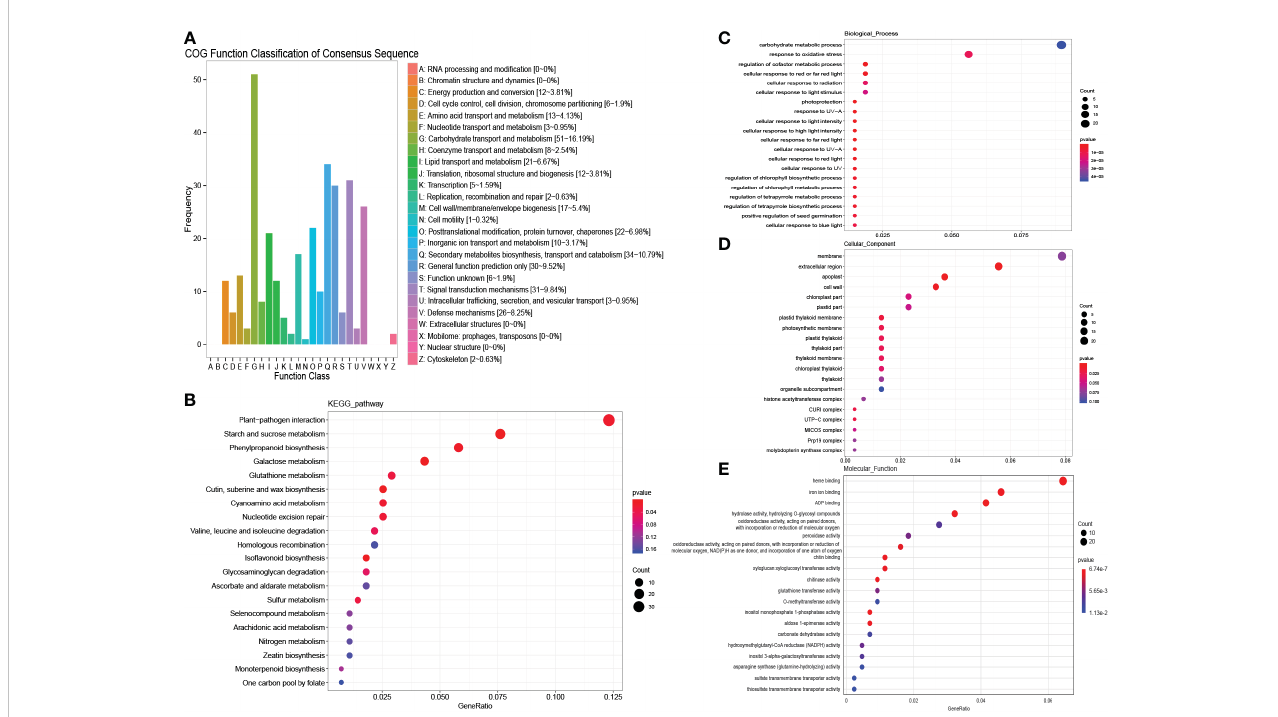
FIGURE 6 COG, KEGG and GO analysis of male unique salinity stress responding genes. (A) COG enrichment analysis of male unique salinity stress responding genes. (B) KEGG enrichment analysis of male unique salinity stress responding genes. (C – E) GO enrichment analysis of male unique salinity stress responding genes.